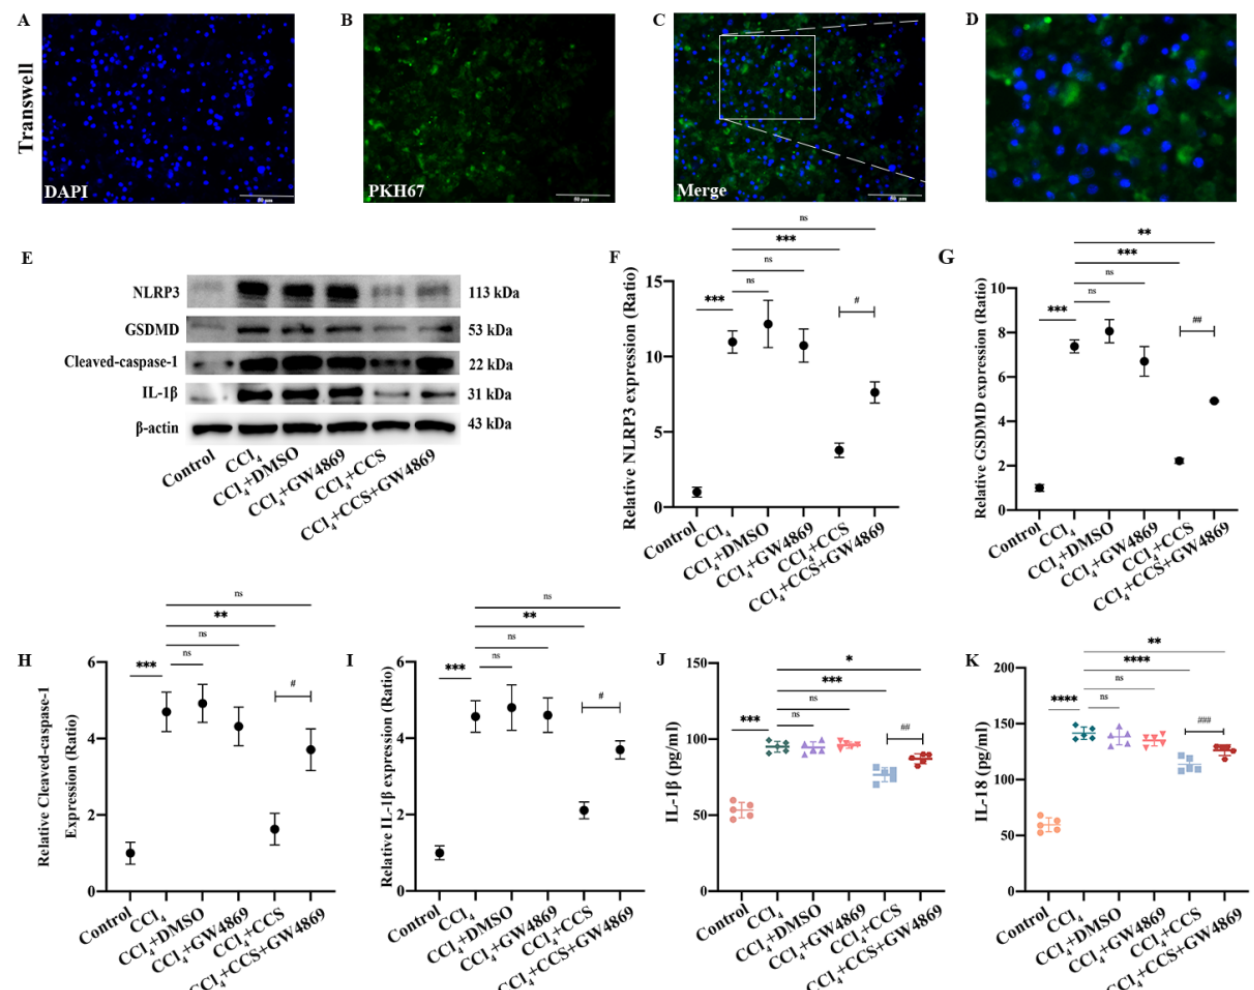
Figure 2. Paracrine effect by which rBMMSCs inhibit hepatocyte pyroptosis. PKH67 dye was trans- ferred to hepatocytes by rBMMSCs via the paracrine pathway (( A – D ), Scale bar = 50 µ m). Pyroptosis- related proteins in the CCl 4 + CCS group were significantly decreased compared to those in the CCl 4 group (( E – I ), ** p < 0.01). Pyroptosis-related proteins in the CCl 4 + CCS+GW4869 group were significantly increased comparing with those in the CCl 4 + CCS group (( E – I ), # p < 0.05). The expres- sion levels of pyroptosis-related proteins in the CCl 4 + DMSO and CCl 4 + GW4869 groups was not significantly different compared to that in the CCl 4 group ( E – I ). Cell viability in the CCl 4 + CCS group was significantly higher than that in the other groups (( J ), ## p < 0.01). The expression of IL-1 β in the CCl 4 + CCS group was dramatically lower than those in the CCl 4 group (( J ), *** p < 0.001). Similar results had been showed in ( K ), the expression of IL-18 in the CCl 4 + CCS group were significantly decreased compared to those in the CCl 4 group (**** p < 0.0001). The data are displayed as the means ± SD; n = 5 for each group.